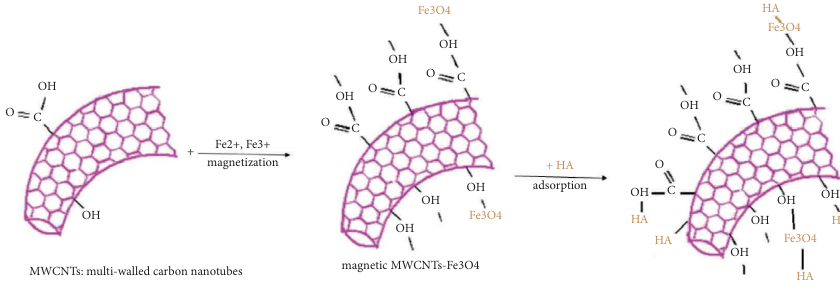
Figure 9: Illustration of the adsorption mechanism of HA on the composite MWCNTs-Fe